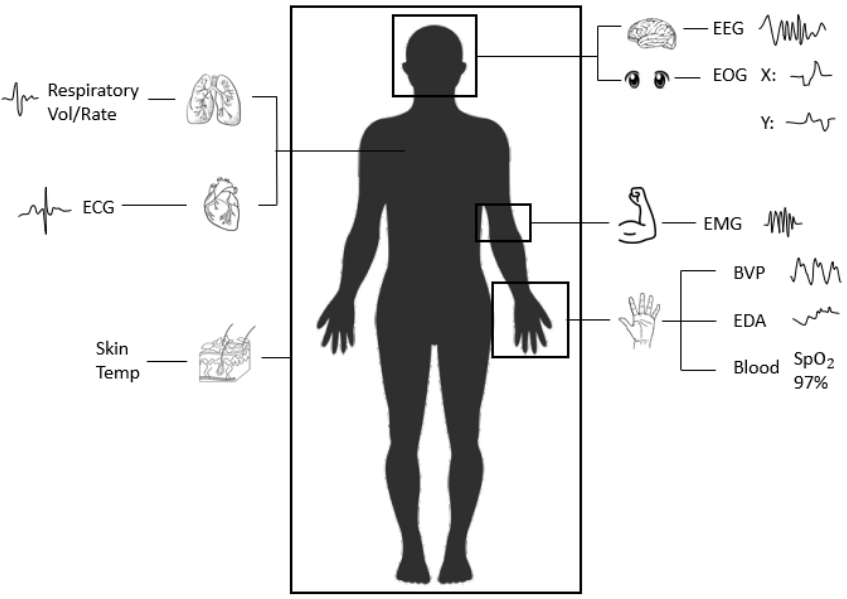
Figure 1. Several physiological signals with